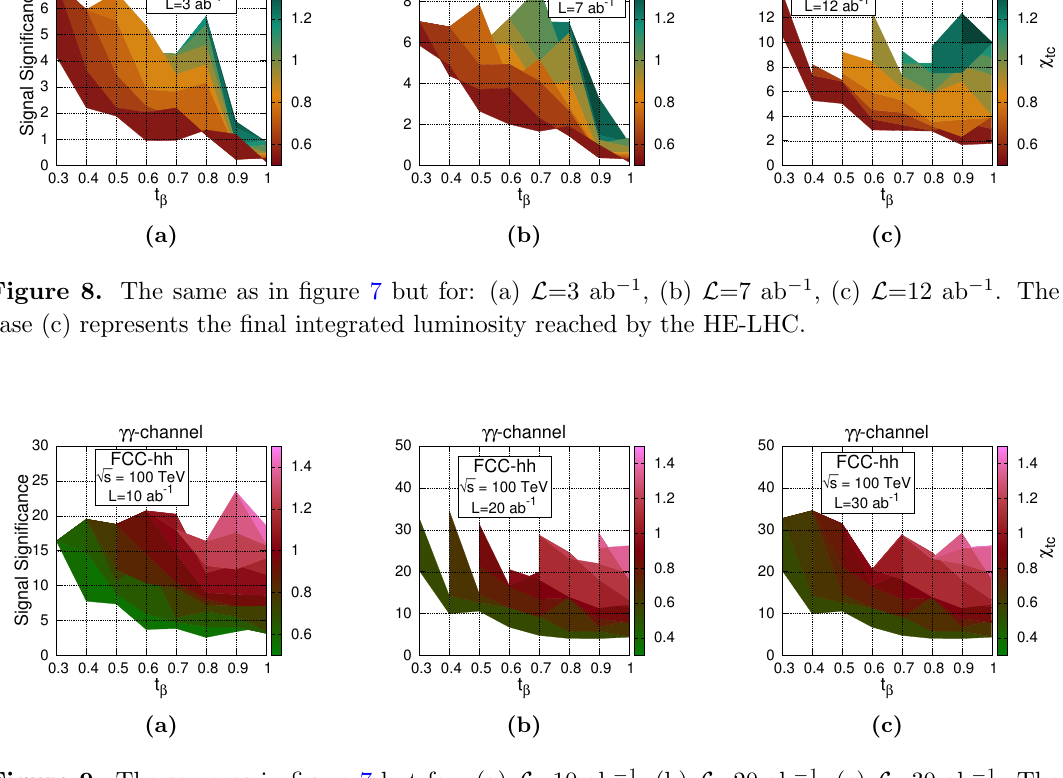
Figure 9. The same as in (cid:12)gure 7 but for: (a) L =10 ab (cid:0) 1 , (b) L =20 ab (cid:0) 1 , (c) L =30 ab (cid:0) 1 . The case (c) represents the (cid:12)nal integrated luminosity reached by the FCC-hh.